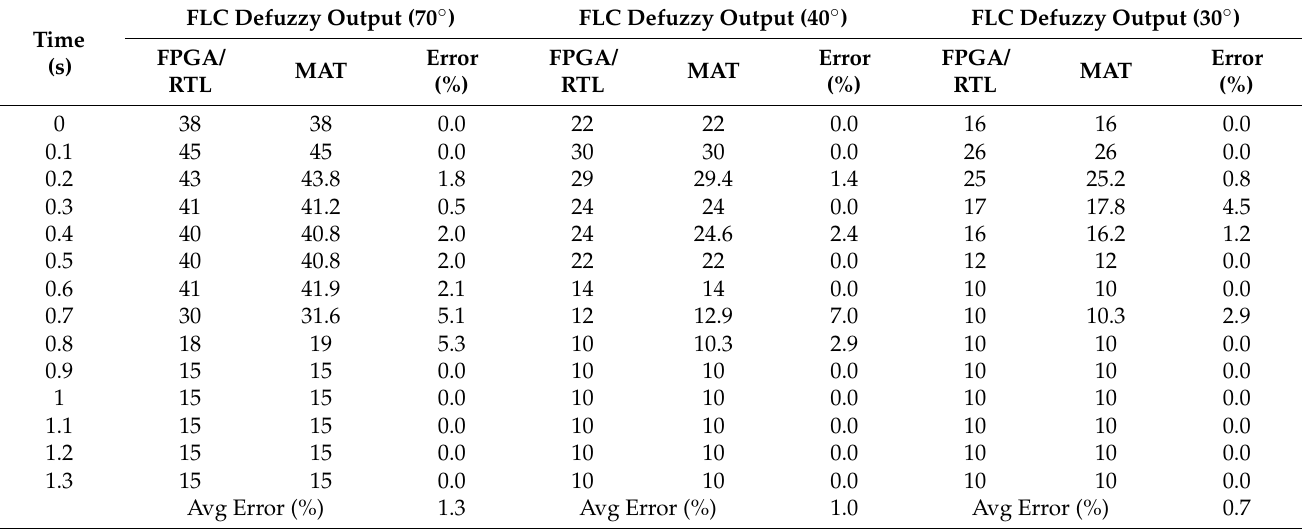
Table 6. Defuzzy output values from hardware measurement using the FPGA (DE2-115) board, RTL simulations